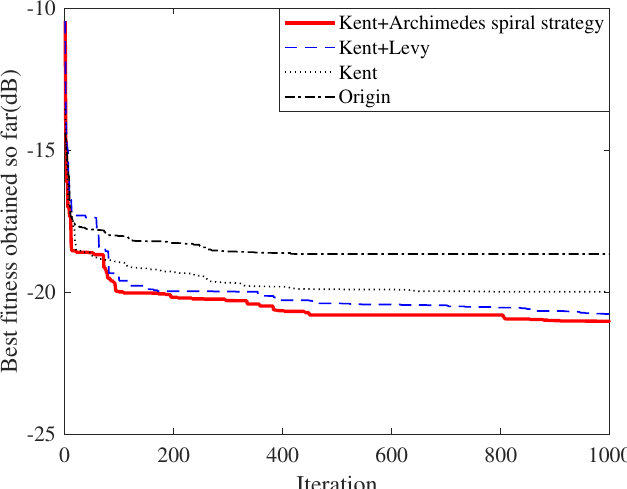
Figure 8. The iterative process under three search path planning strategies.